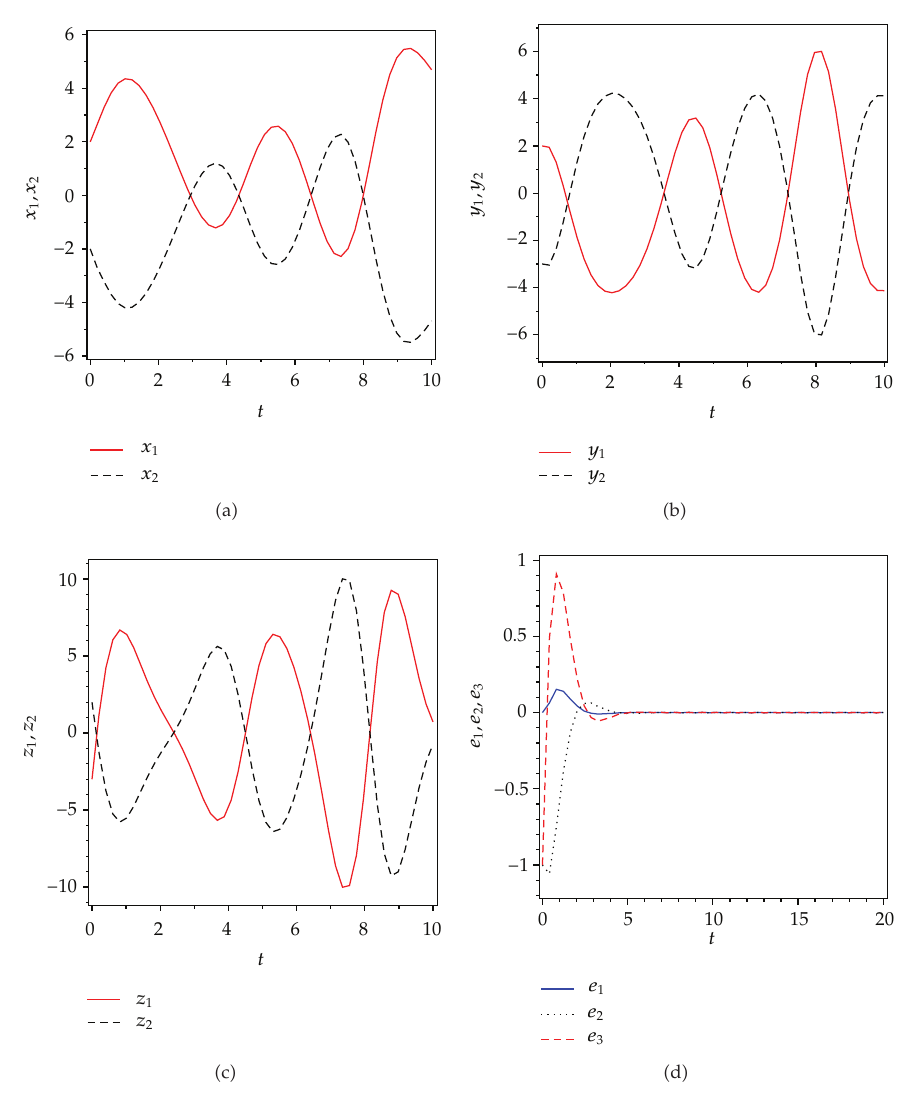
Figure 2: State trajectories of drive system (cid:7) 4.9 (cid:10) and response system (cid:7) 4.10 (cid:10) , (cid:7) a (cid:10) signals x 1 and x 2 ; (cid:7) b (cid:10) signals y 1 and y 2 ; (cid:7) c (cid:10) signals z 1 and z 2 ; (cid:7) d (cid:10) the error signals e 1 , e 2 , e 3 between two identical Genesio systems with di ff erent initial conditions under the controller (cid:7) 4.14 (cid:10) .